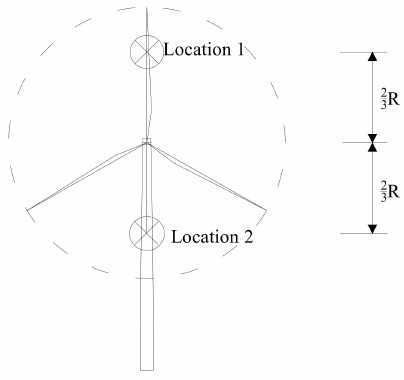
Figure 1. Computational locations for V 1 and V 2